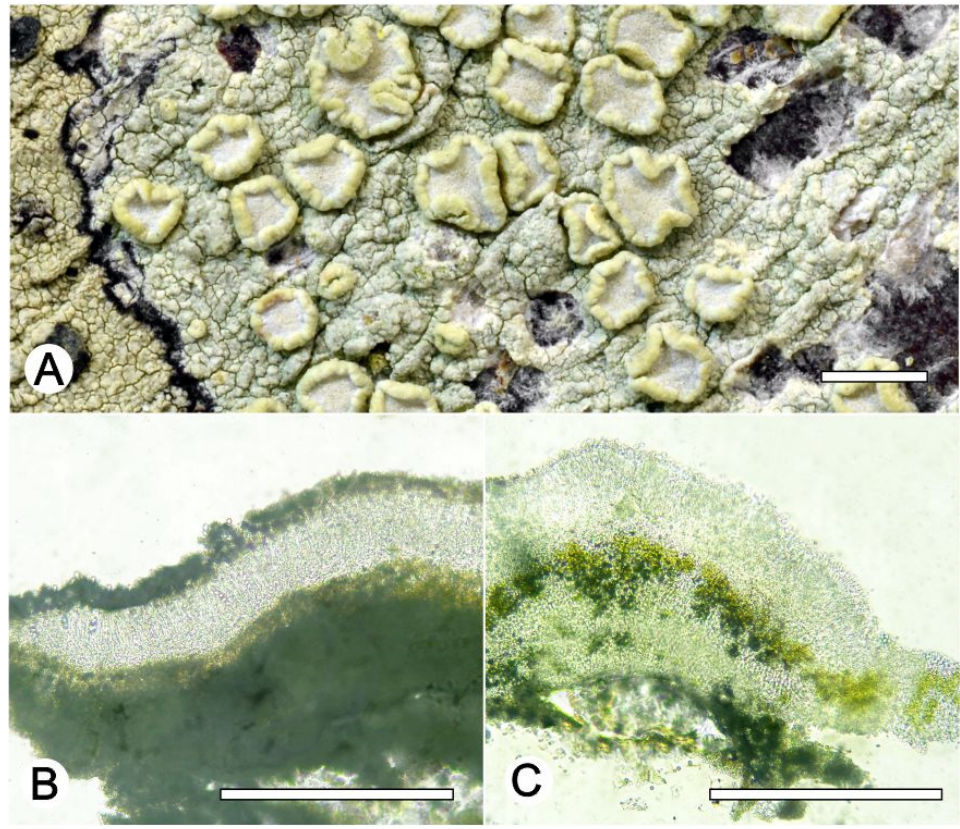
Figure 2. Lecanora flavocaesia sp. nov. ( A ) Thallus with ascomata (holotype ISE-46521a); ( B ) Apothecial section in water (holotype ISE-46521a); ( C ) Apothecial section after KOH treatment (holotype ISE-46521a). Scale bars: ( A ), 1 mm; ( B , C ), 100 µm.